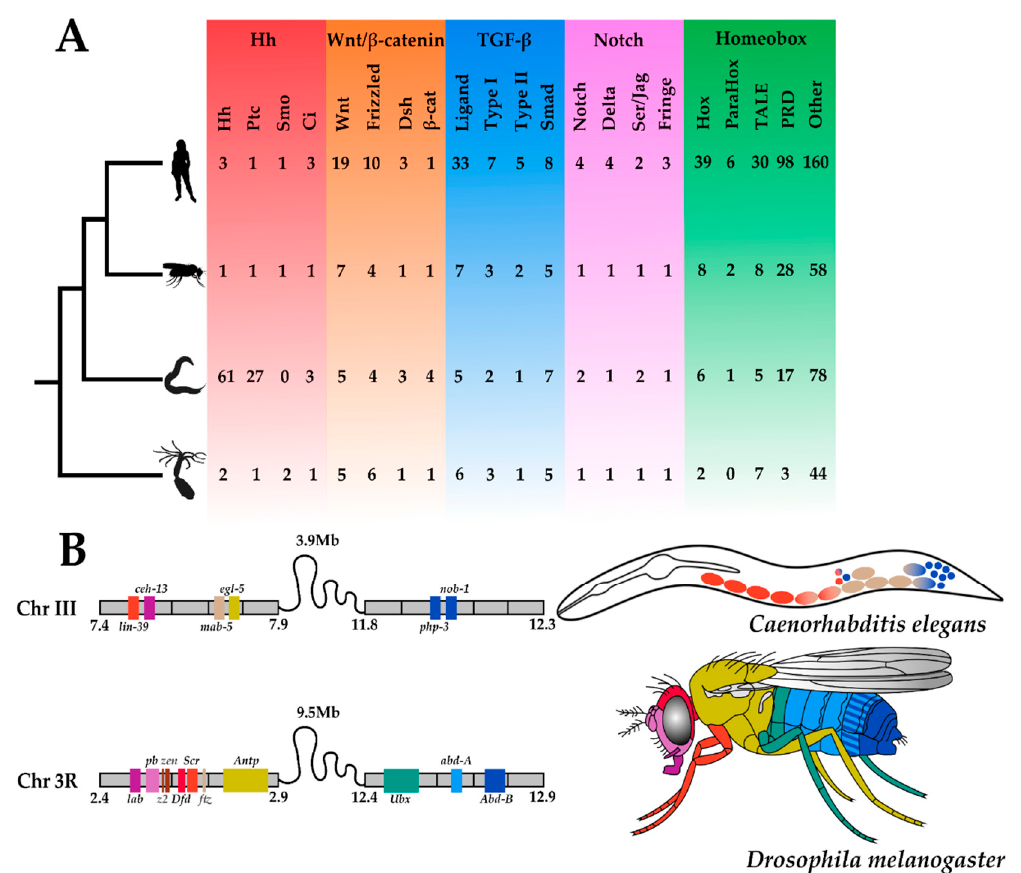
Figure 2. Metazoan Toolkit Evolution. Panel ( A ) depicts the phylogenetic relationships between four metazoan species, from the top: Homo sapiens , Drosophila melanogaster , Caenorhabditis elegans , and Nematostella vectensis . Silhouettes of animals were obtained from http: // phylopic.org (open source). Their gene toolkits, from the left. Hedgehog (red): Hedgehog (Hh), Patched (Ptc), Smoothened (Smo), Cubitus Interruptus (Ci); Wnt (orange)- sensu stricto : ‘Wingless-related Integration site’ (Wnt), Frizzled, Dishevelled (Dsh), β -cat ( β -catenin); Transforming Growth Factor- β (TGF- β ) (blue)- sensu lato : Ligand, Type I receptor, Type II receptor, Smad (Small Mothers Against Decapentaplegic); Notch (purple)- sensu stricto : Notch, Delta, Serrate / Jagged (Ser / Jag), Fringe; Homeobox (green): Hox, ParaHox, TALE (Three Amino Acid Loop Extension), PRD (Paired), Other (all other additional homeobox genes mined from the proteomes); are depicted. All copy numbers were obtained by the authors of this review from mining the predicted proteomes of H. sapiens , D. melanogaster , C. elegans and N. vectensis using reciprocal (NCBI) BLASTp searches. Panel ( B ) depicts the Hox clusters of C. elegans and D. melanogaster . Their genomic location with an approximate scale (Mb = Megabase) and syntenic relationships are schematised, where gene colours denote Hox orthogroups. These colours are also used to depict the gene expression in the adults of these two